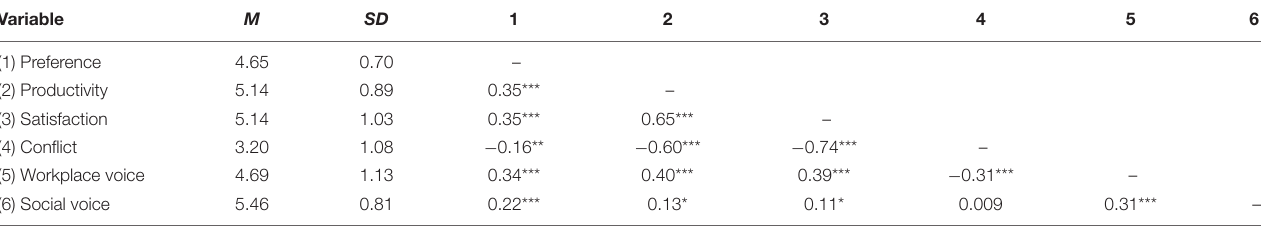
TABLE 5 | Descriptive statistics and correlations among study variables.